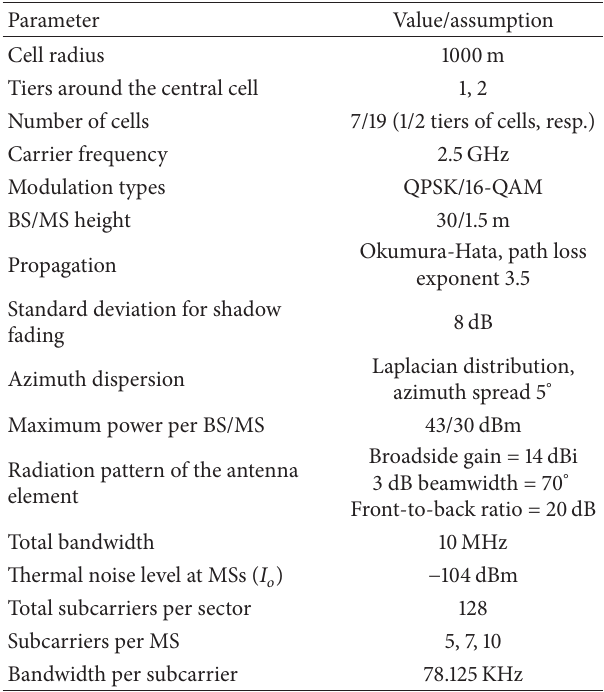
Table 1: Simulation